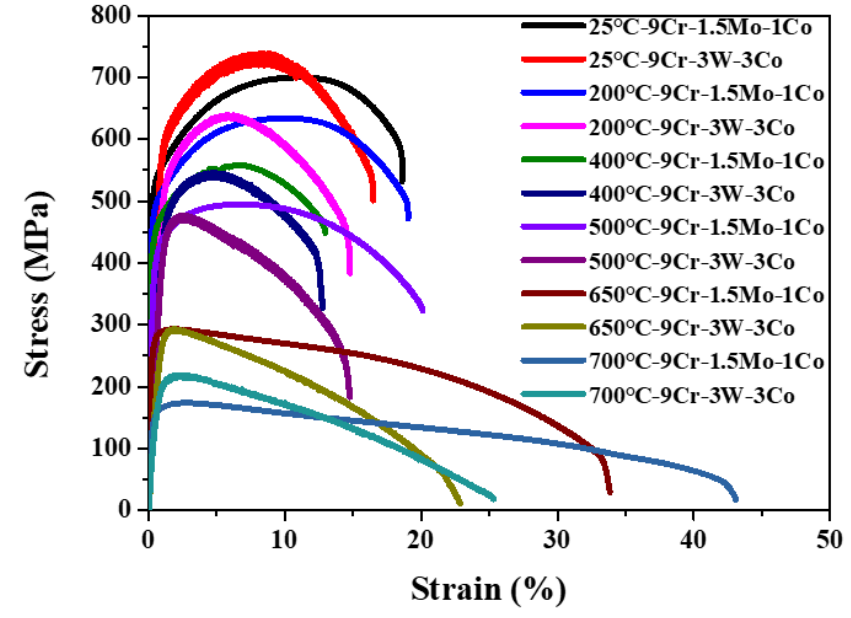
Figure 2. The stress–strain curves of 9Cr–1.5Mo–1Co and 9Cr–3W–3Co heat-resistant steel.